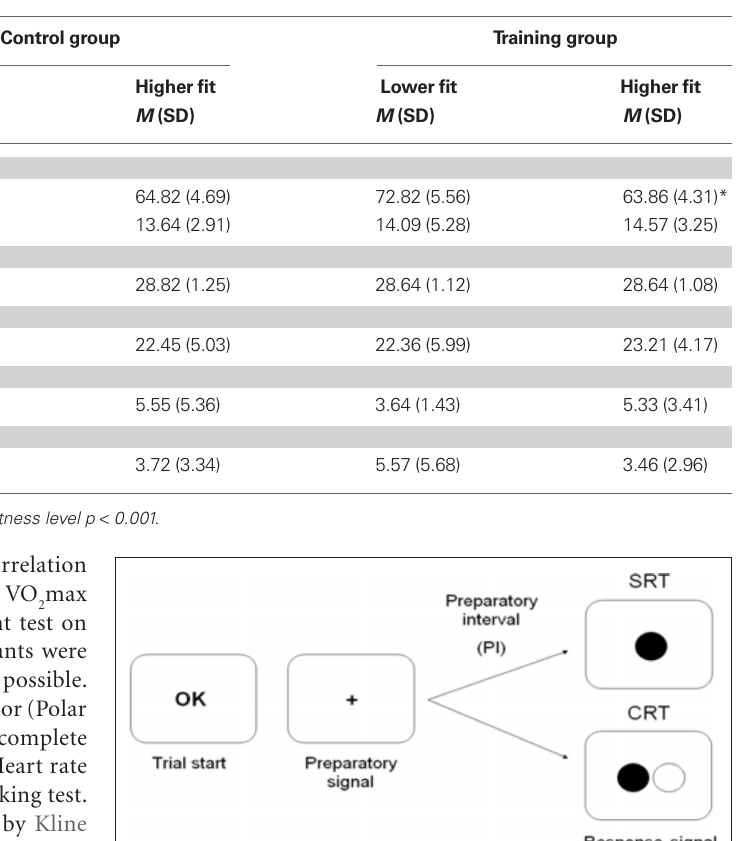
Table 1 | Participants’ baseline characteristics as a function of baseline fitness level.